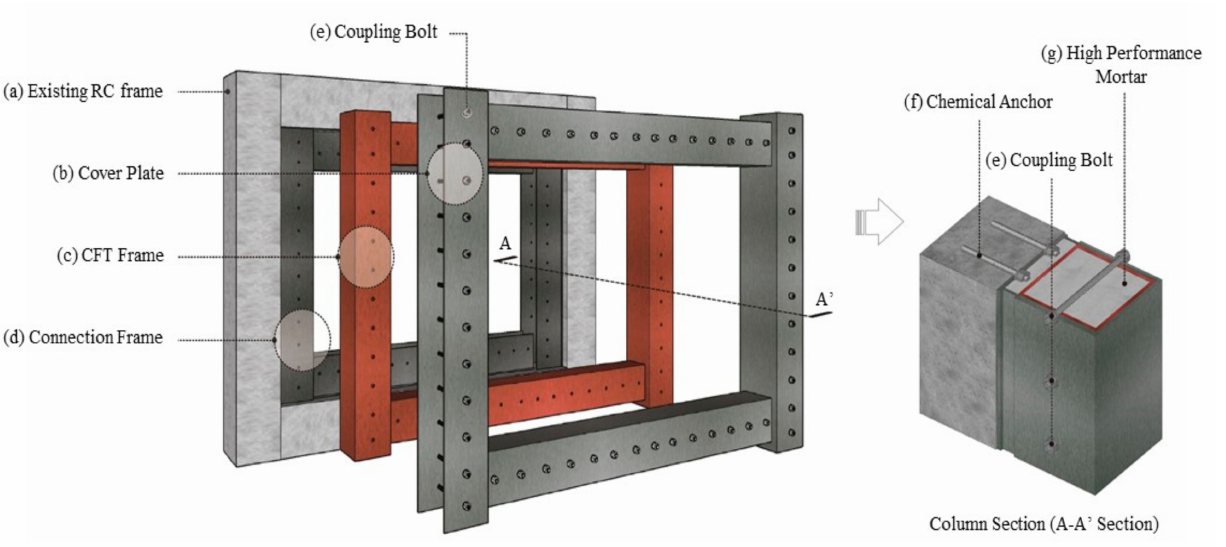
Figure 4. Detailed illustration of CFT-MF strengthening